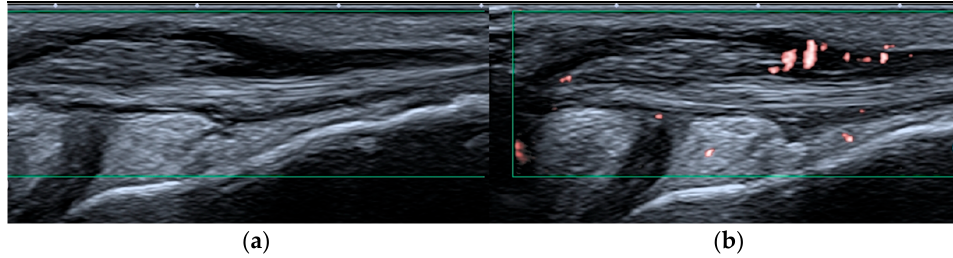
Figure 2. Peroneal tenosynovitis in a 6-year-old girl. Long-axis power Doppler ultrasound image (green rectangles) of the peroneal tendons ( a ) shows no hyperemia, which is evident on the more sensitive superb microvascular imaging ultrasound image ( b ), consistent with active tenosynovitis. Microvascular imaging, as with superb microvascular imaging (SMI), is a recent in- novative Doppler technology. It is more sensitive than color Doppler US (CDUS) and power Doppler US (PDUS) [28,29] because it can visualize very-low-velocity flow (less than 1 cm/se) in microvessels with high resolution without the need to use a contrast me- dium [30,31]. Color SMI (cSMI) displays low-flow components in color overlaid on a grey- scale image with simultaneously high temporal and spatial resolution, and